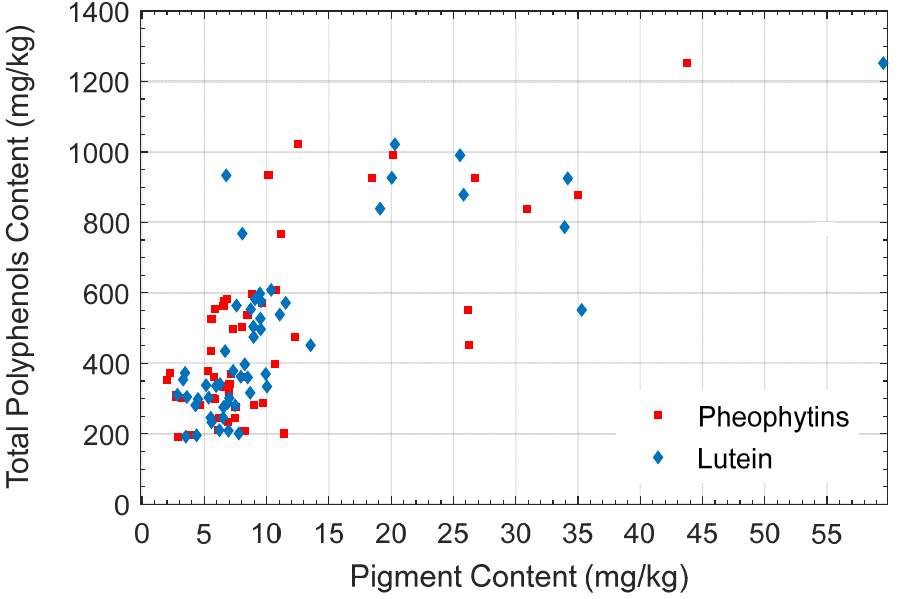
Figure 1. Scatter plot of the total polyphenol content and the pheophytin and lutein pigment content.